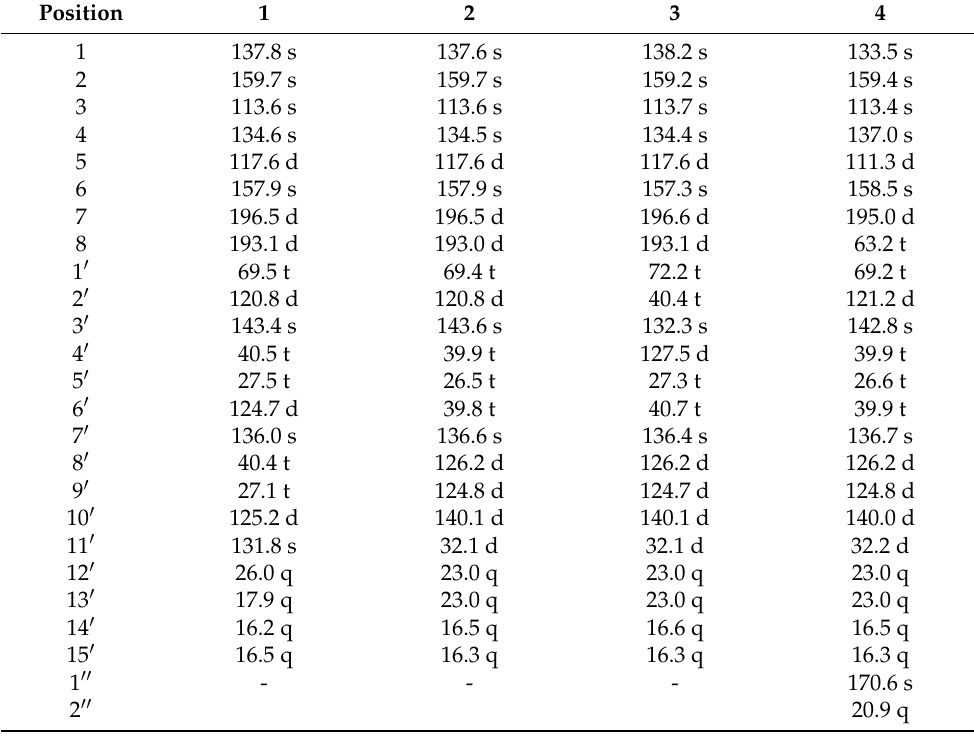
Table 2. 13 C-NMR data for compounds 1 – 4 (125 MHz, Acetone-d 6 ).